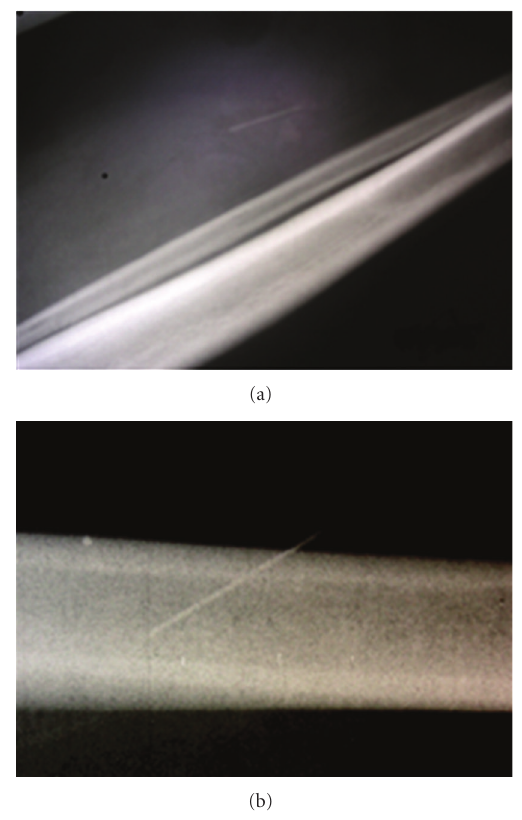
Figure 4: (a) and (b) Standard X-ray of the lower right leg showing presence of the sewing